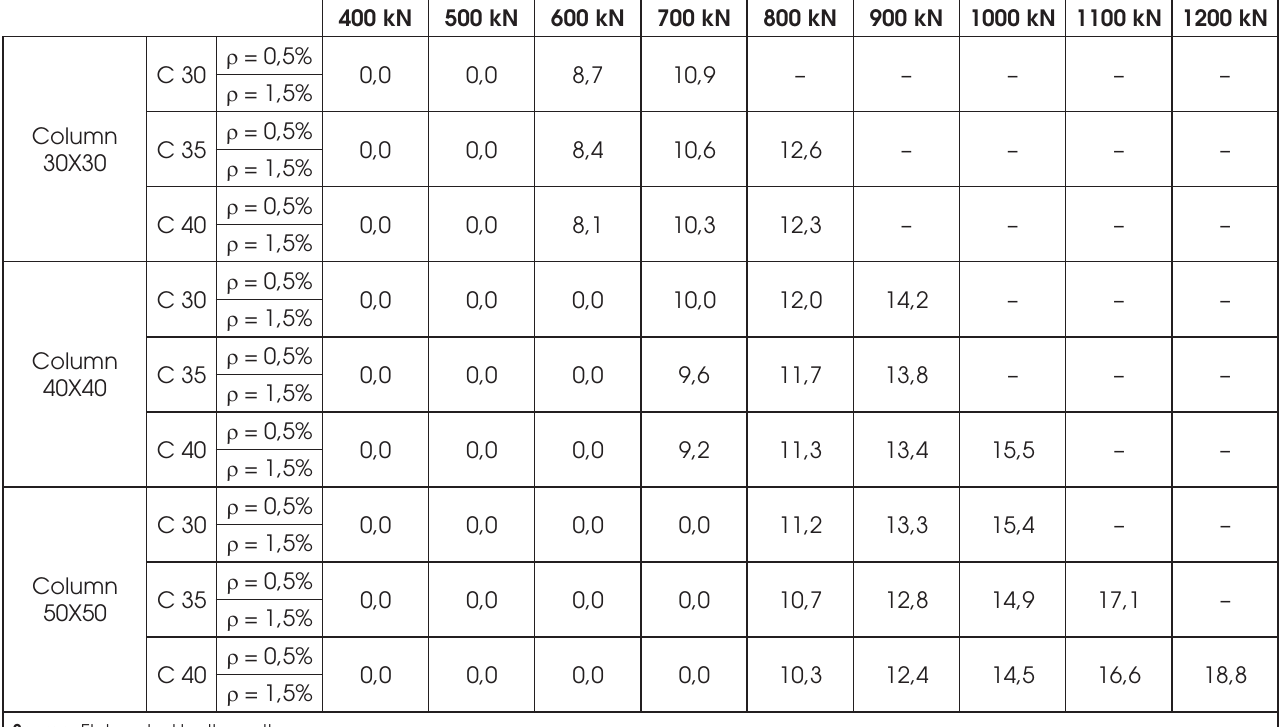
Area of shear reinforcement (cm²) by ACI 318-11 (analysis